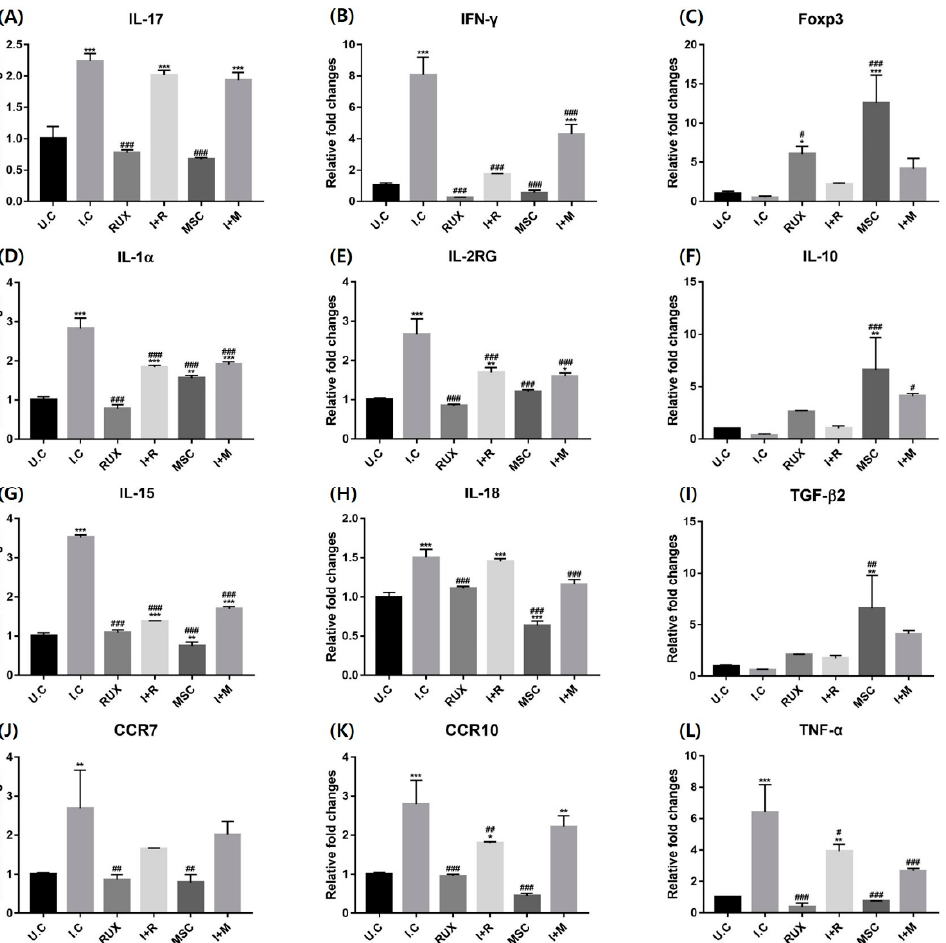
Figure 5. Effects of allogenic hMSC treatment on molecules related to inflammatory markers in IFN-treated PBMCs at the mRNA level. The mRNA expression of ( A ) IL-17, ( B ) IFN- γ , ( C ) Foxp3, ( D ) IL-1 α , ( E ) IL-2R γ , ( F ) IL-10, ( G ) IL-15, ( H ) IL-18, ( I ) TGF- β , ( J ) CCR7, ( K ) CCR10, and ( L ) TNF-